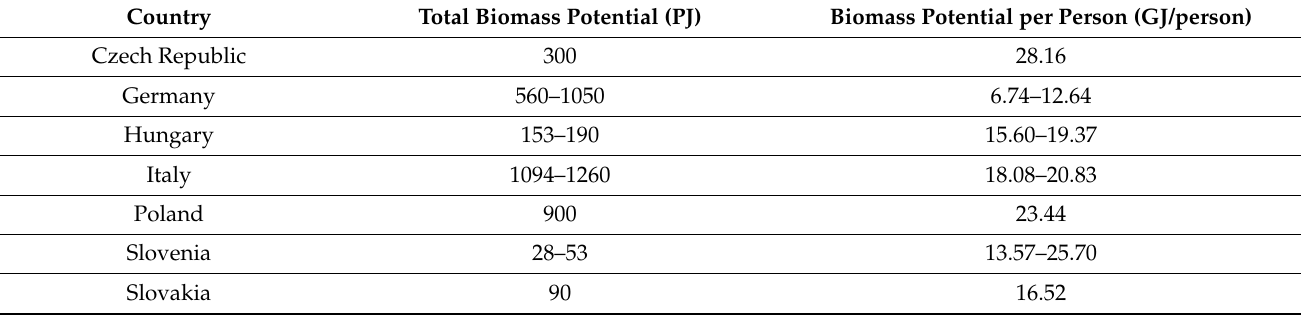
Table 5. Biomass potential for Central European countries per capita (where: 1 PJ = 10 9 MJ, 1 GJ = 10 3 MJ). Country Total Biomass Potential